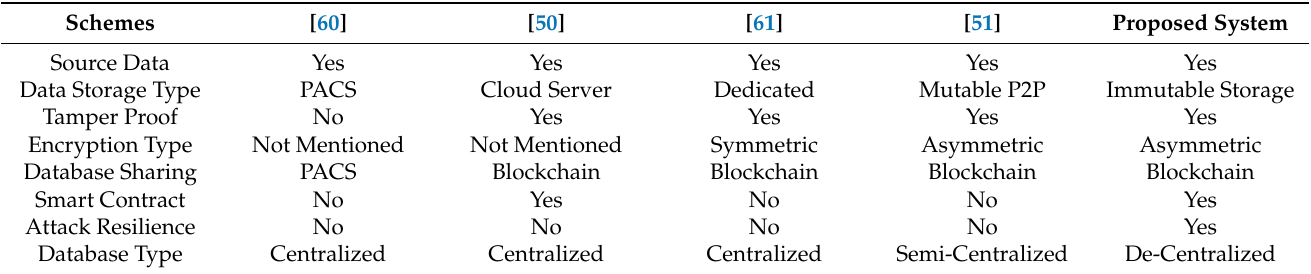
Table 2. Comparison between existing frameworks and the proposed